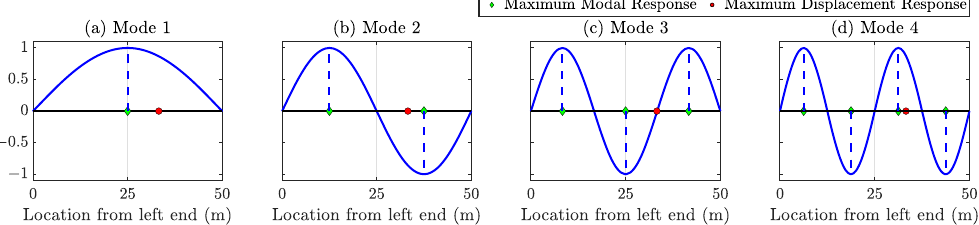
Figure 17. Location of the maximum displacement response is denoted as a ‘red circle’—which is impossible to obtain without the dense sensing. Even the knowledge of the maximum modal responses of different modes is not enough to find the location of the maximum displacement response. The location of maximum amplitude is very close to the node point of mode